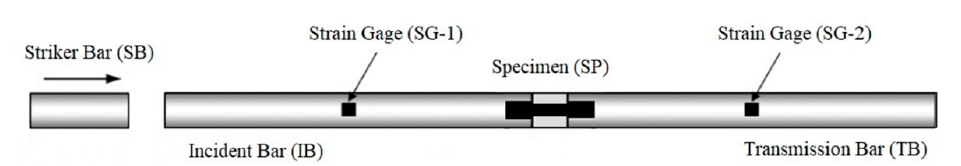
Figure 1. Split Hopkinson pressure bar apparatus.